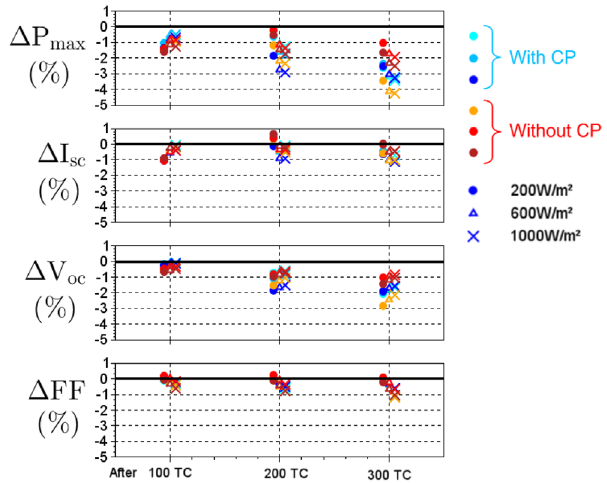
Fig. 13. Flash test losses compared to initial time for thermal cycling